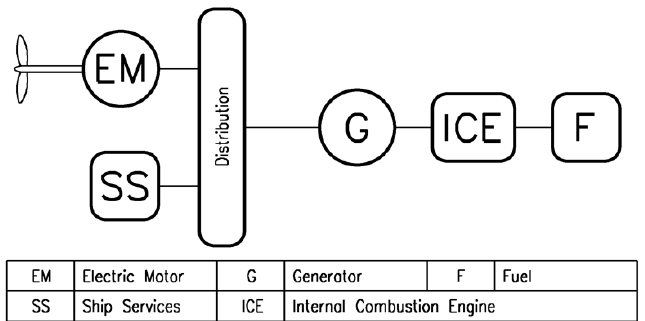
Figure 6. Integrated power system architecture.